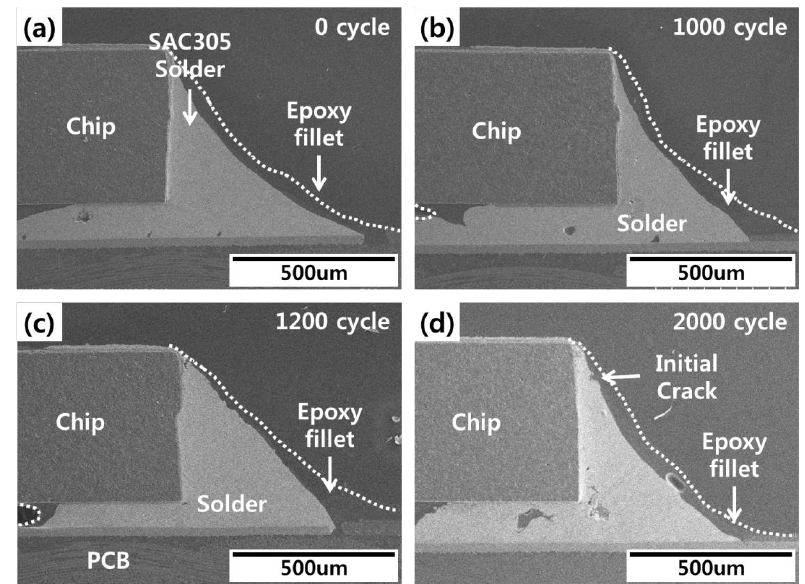
Figure 10. Epoxy SAC305 solder joint images during thermal shock test ( a ) 0 cycles, ( b ) 1000 cycles, ( c ) 1200 cycles, and ( d ) 2000 cycles.